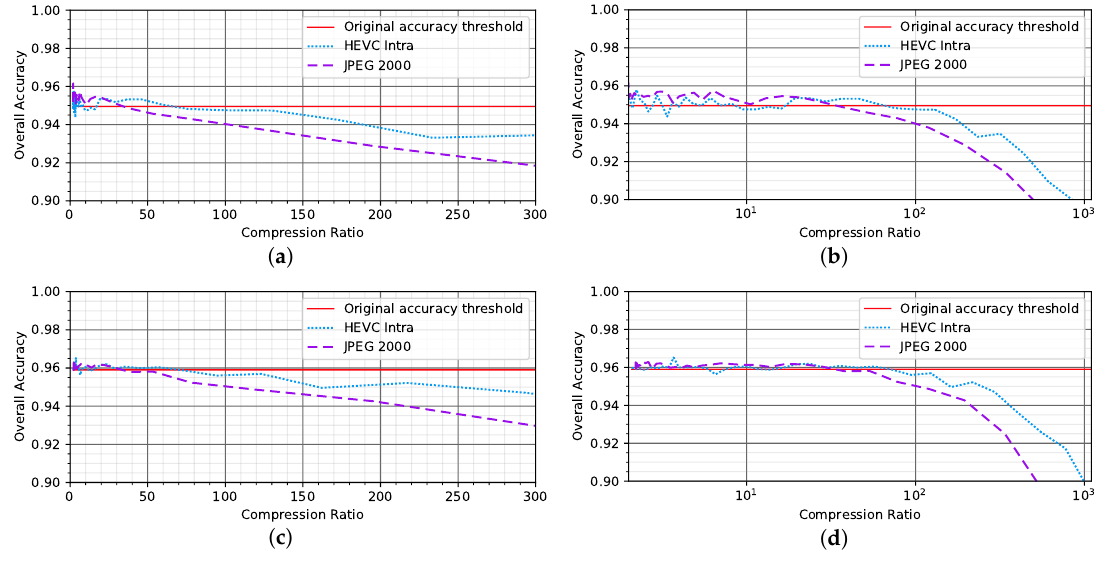
Figure 10. Sensitivity of classification performance, as illustrated by the overall classification accuracies (OAs) against the compression ratios (CRs) achieved by the HEVC intra and the JPEG 2000 image codecs. Diagrams ( a , b ) and ( c , d ) correspond to experiments based on time series R036 and R136, while the solid red lines denote OAs of the “original” classifier instances reported in Table 5. Higher CRs are given in log scale in ( b , d ). Table 5. Accuracy assessment matrices for two classifier instances based on the original, uncompressed time series data, R036 and R136. Symbols are the same as in Table 2. Values represent number of pixels in 10 3 . Column labels denote classifier decisions, while the row labels represent true crop categories. the bottom of the